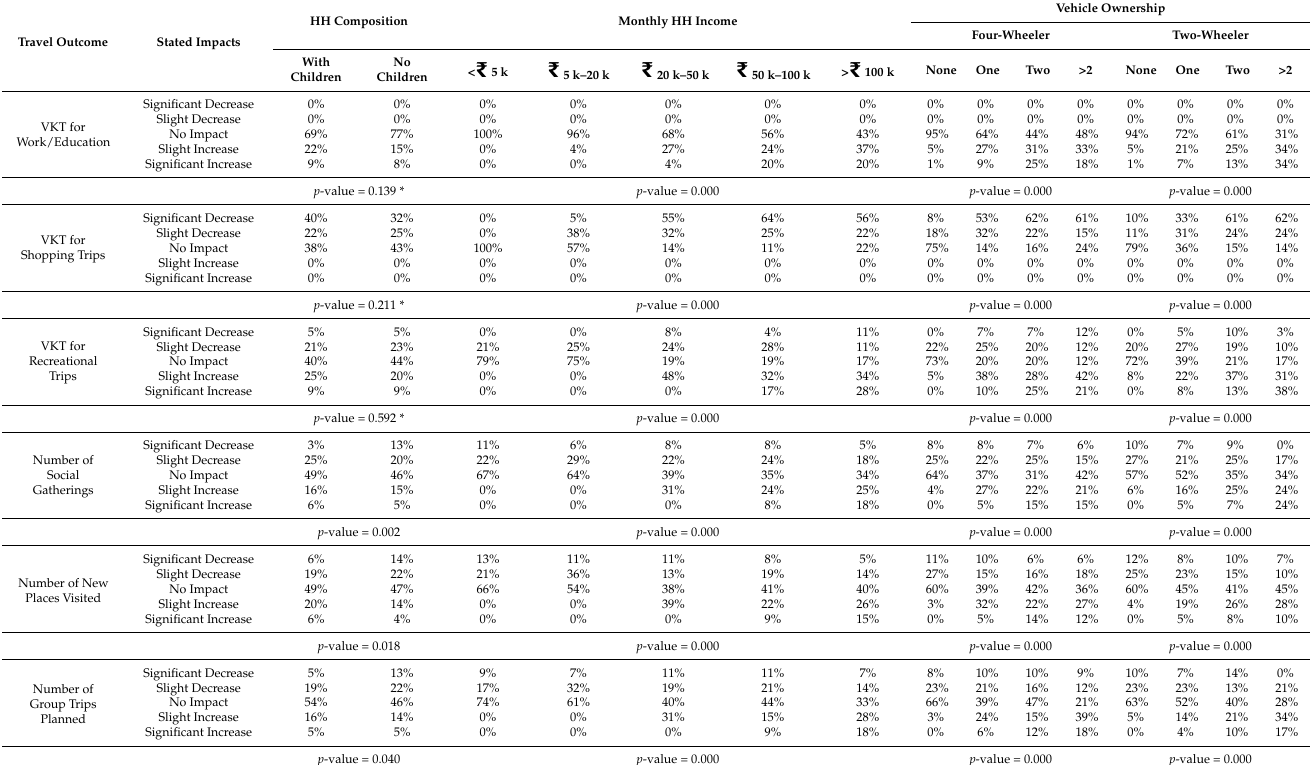
Table 5. Household-level attributes and travel outcome-wise classification of smartphone app users.